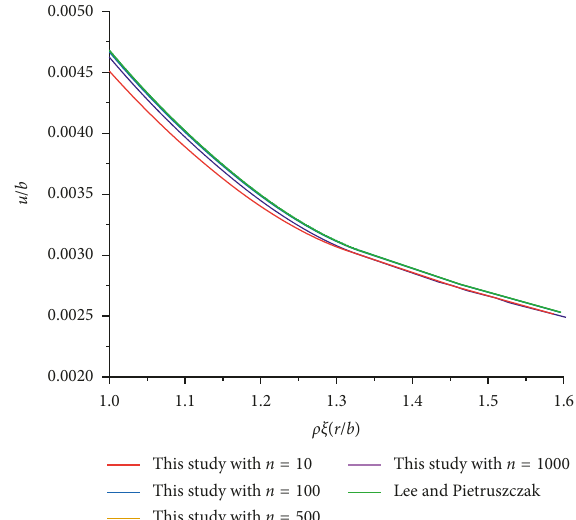
based on the generalized ∗